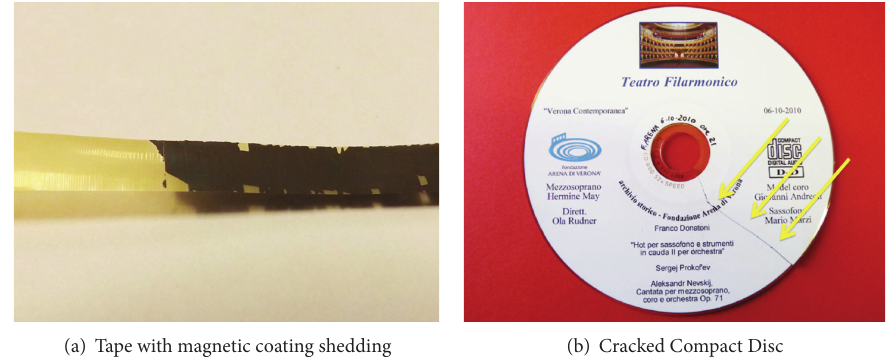
Figure 5: (a) Magnetic tape 1/4-inch-wide with magnetic coating shedding (“a failure of the binder/oxide coating to adhere to the substrate film, resulting in the delamination—the peeling away—of one from the other” [32]). (b): Compact Disc exhibiting a longitudinal crack (“a break without physical separation” [19, Appendix